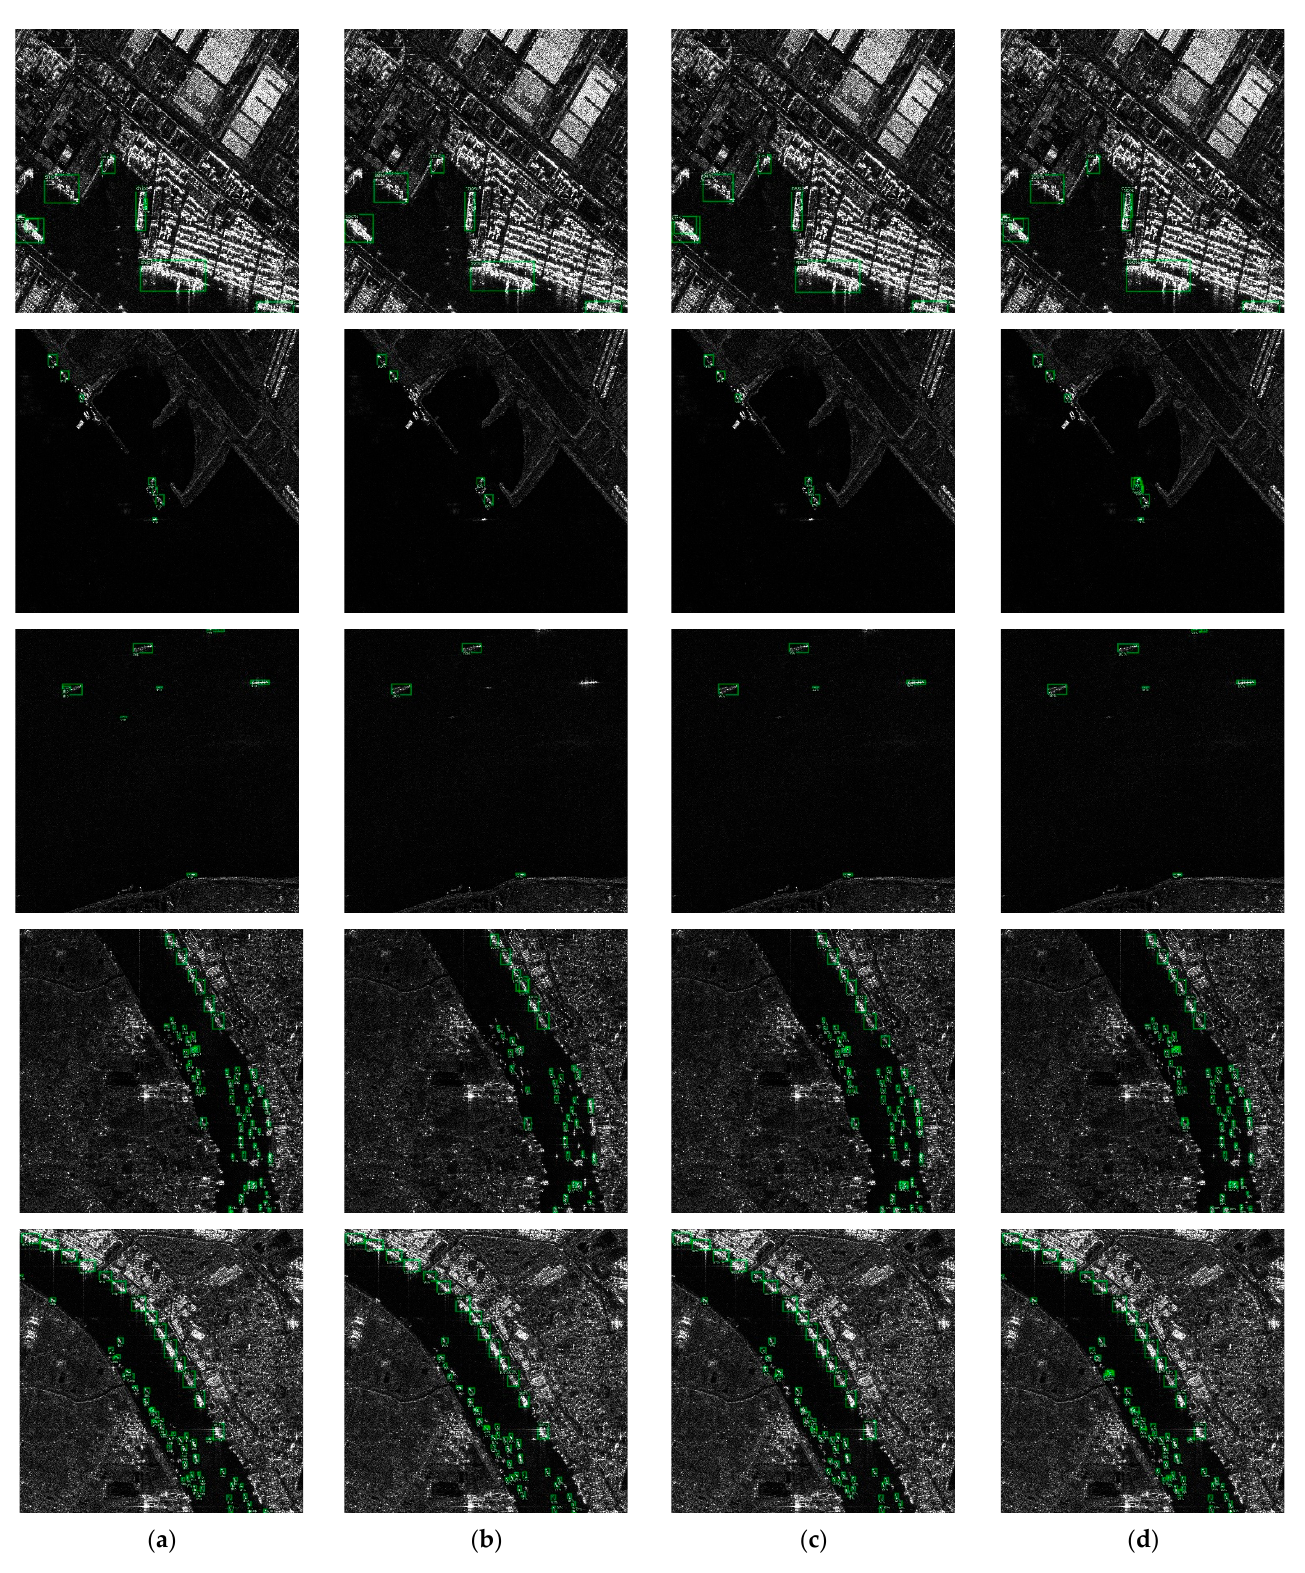
Figure 10. Visualization results of ablation experiments on the HRSID. ( a ) Ground truths. ( b ) Detection results of FCOS trained by focal loss. ( c ) Detection results of FCOS trained by GAP loss. ( d ) Detection results of FCOS with SCSA module trained by GAP loss.